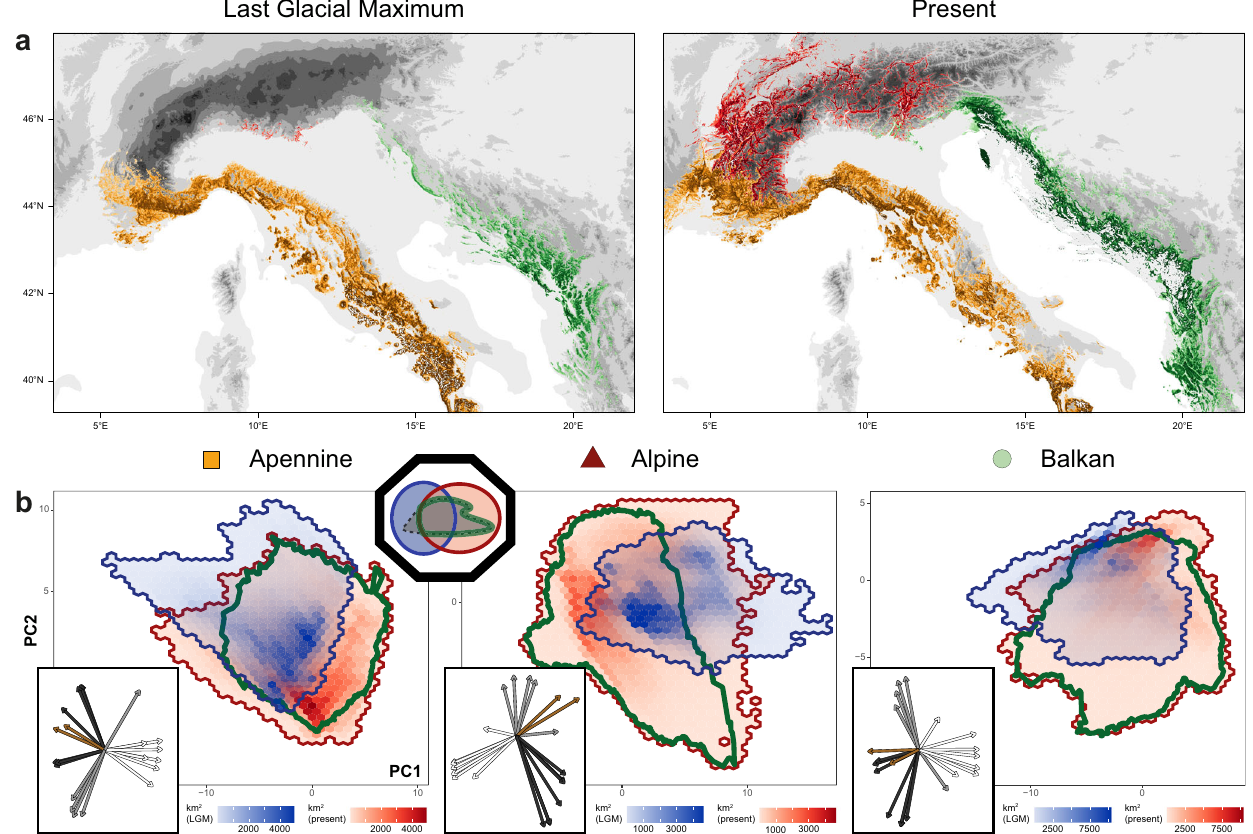
Fig. 4 | Shifts in environmental space dictate past and present ranges. A Lineage-speci fi cdistributionspredictedforthelastglacialmaximum(LGM)(left; i.e., showing glacial refugia) and present-day (right).The predictionofthe present- daydistributionrecapitulatesobservedpatternsofgeneticstructure.Topographic elevation isrepresentedin shades of grey and the sea isshown in white. B Shifts in environmental space and habitat availability from the LGM (blues) to the present- day (reds),forthe Apennine (left),Alpine (middle) andBalkan(right) regions. Each coordinate in this projection of environmental space represents a unique combi- nation of environmental variables. The geographic area (km 2 ) represented by each